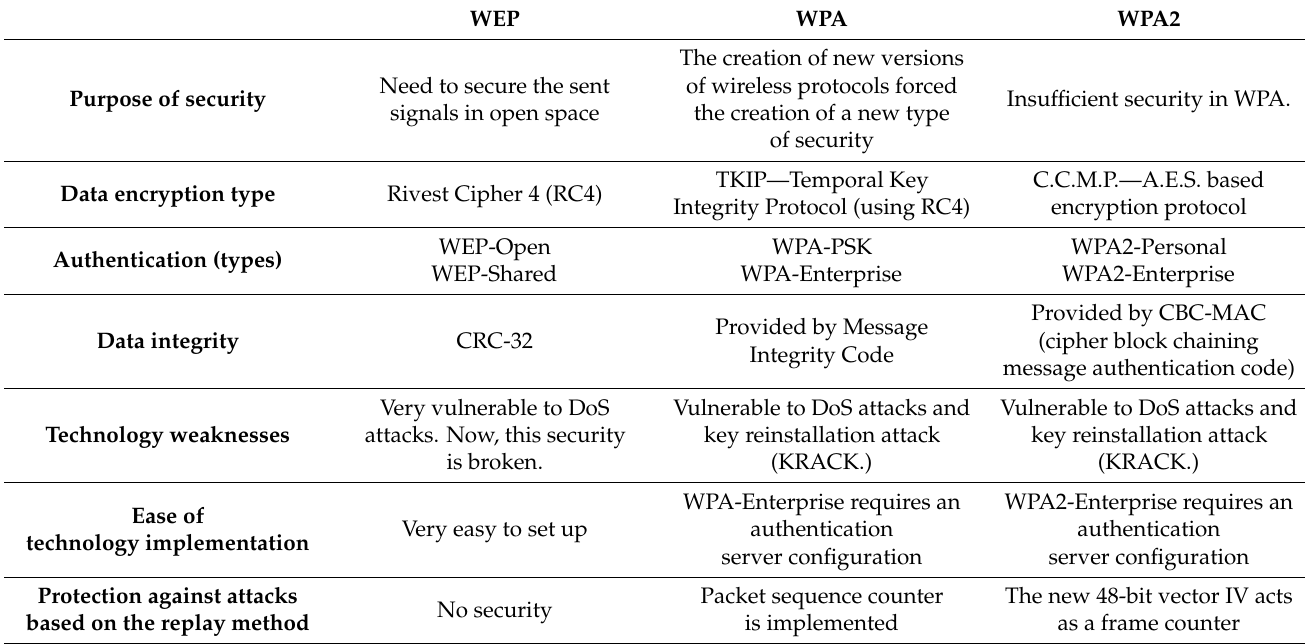
Table 2. Comparison of WEP, WPA, and WPA2 security [21]. WEP WPA WPA2